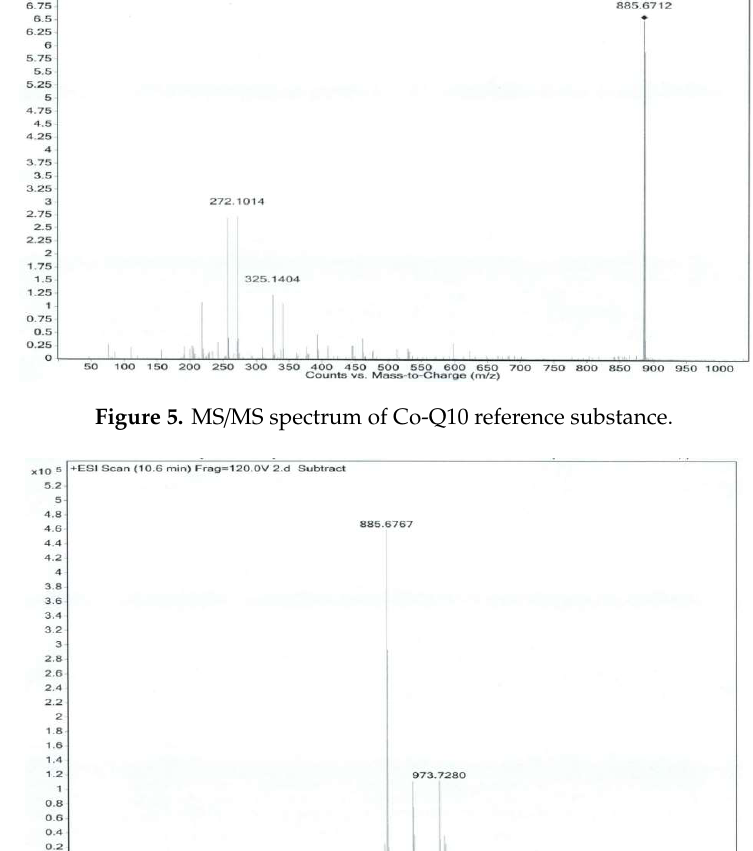
Figure 6. MS spectrum of impurity X.